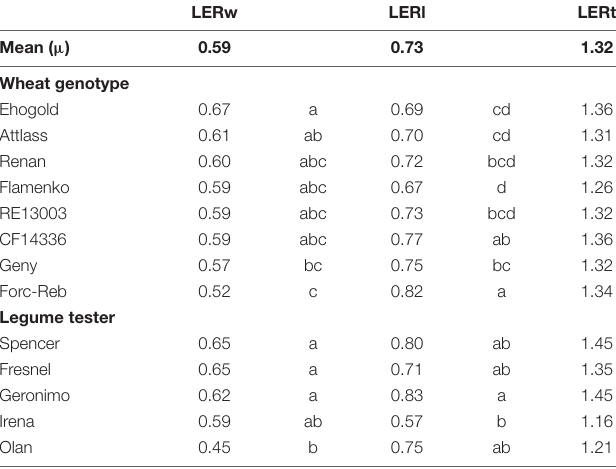
TABLE 7 | Mean partial and total land equivalent ratios (LER) across 9 environments for the 8 wheat genotypes intercropped with the 5 legume testers.